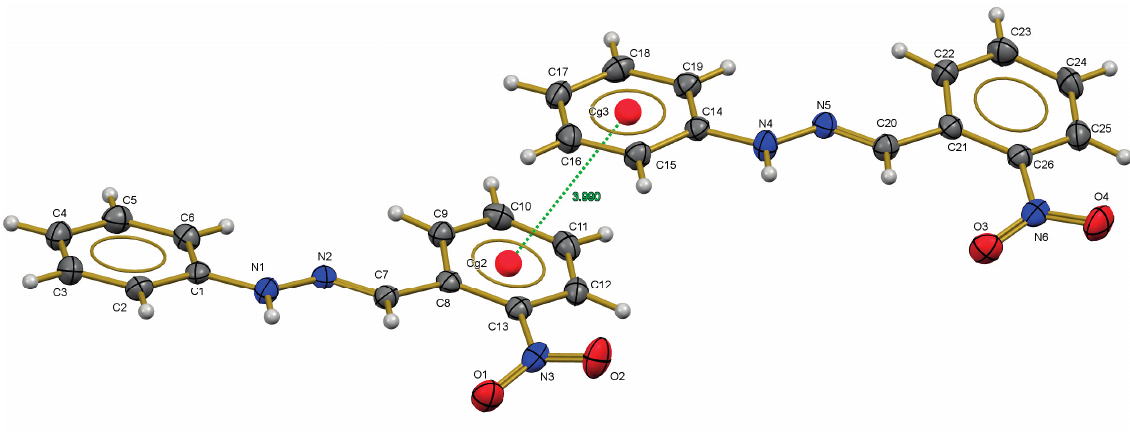
Figure 5. Crystal structure of compound 1 with the thermal ellipsoids drawn at 60% probability.